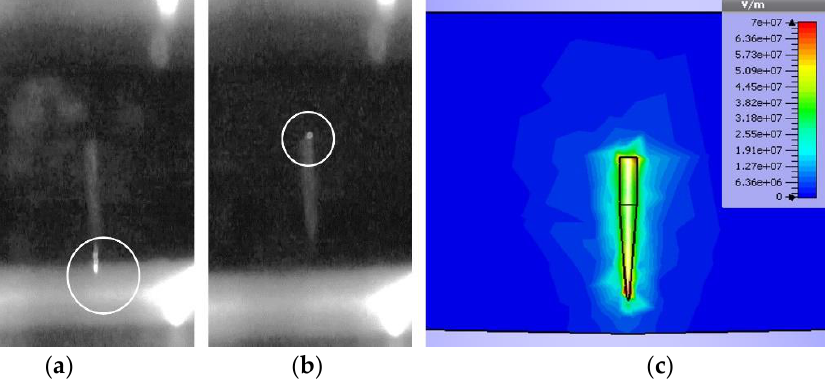
Figure 12. Corona for 10 mm of particle size and d =2 mm at voltage stress of 59.4 kV: ( a ) corona at the bottom of particle; ( b ) corona at the top of particle; and ( c ) simulation result of E -field distribution.